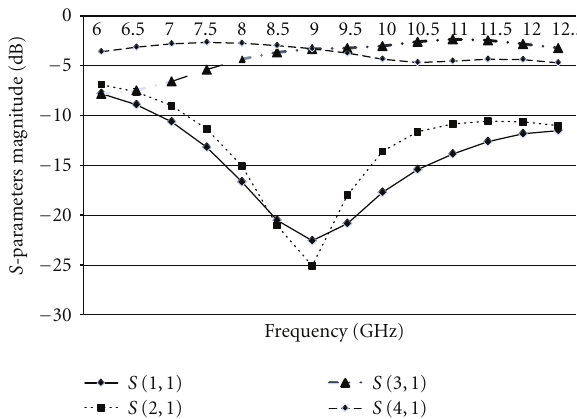
Figure 5: Measurement result for nonuniform branch line coupler.